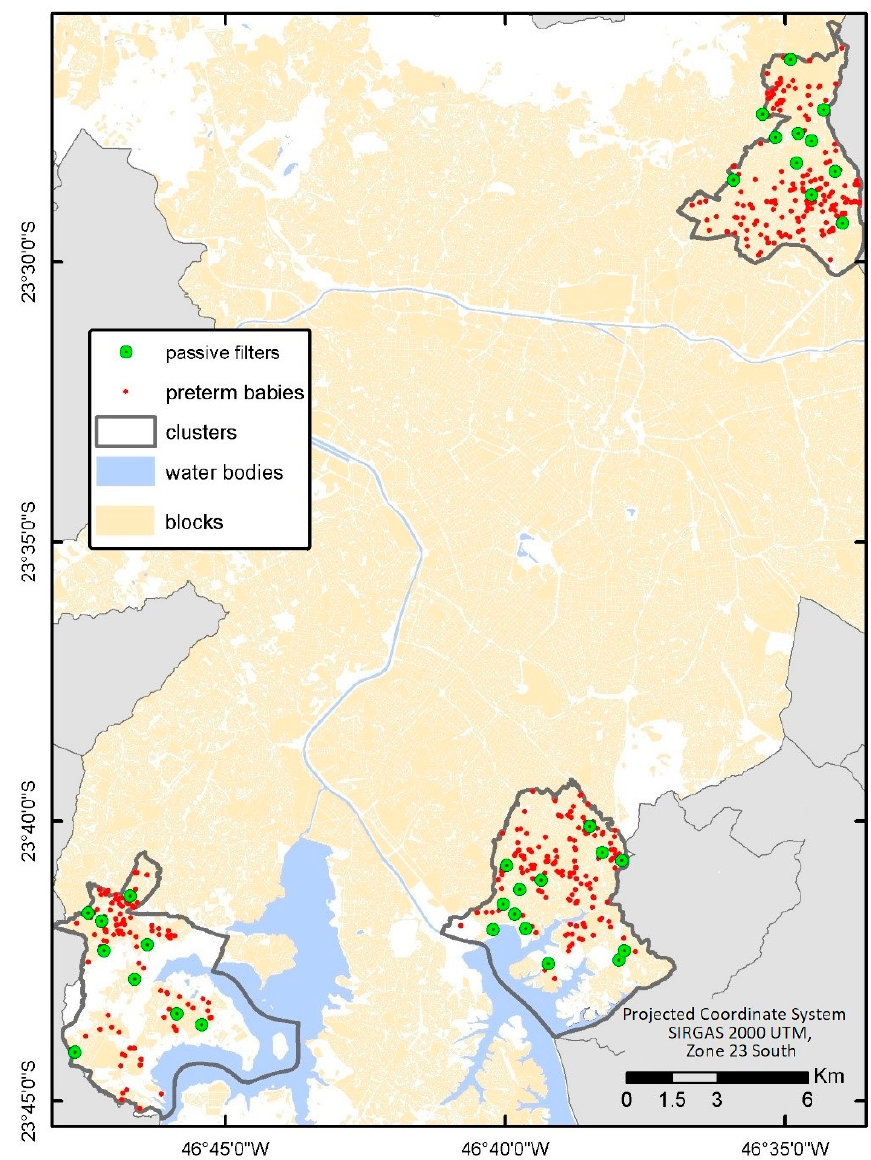
Figure 3. Spatial distribution of filters and interviewed preterm mothers in the studied clusters.